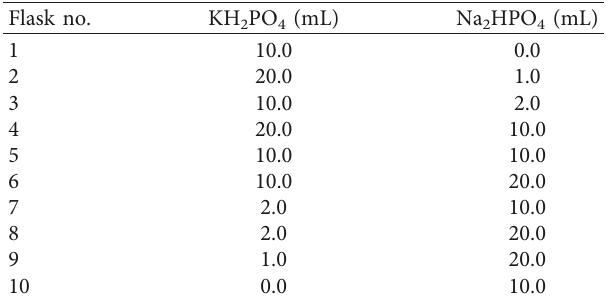
Table 1: Added volumes of 0.1M Na KH 2 PO 4